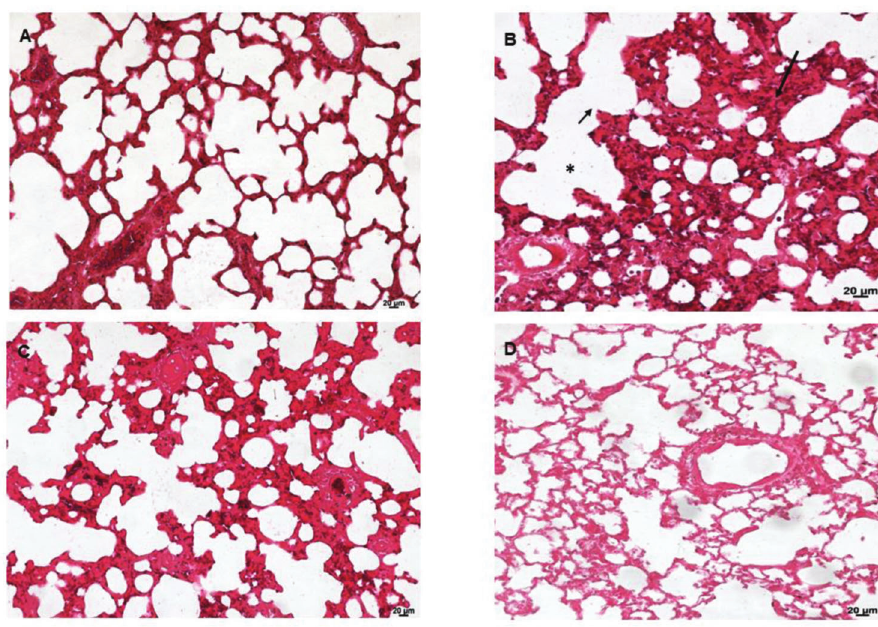
Figure 6 - Lung photomicrograph of rats where melatonin and NAC were administered to attenuate lung injury induced by intestinal ischemia-reperfusion (iLR). A (sham): Normal appearance; B (SS + iIR): alveolar edema (*), destruction of the alveolar septum (small arrow), inflammation (long arrow); C (NAC + iIR): moderate edema/inflammation, destruction of the alveolar septum, and congestion; D (MEL + iIR): mild to moderate congestion, reduced inflammation, and destruction of the alveolar septum. Hemoatoxylin eosin